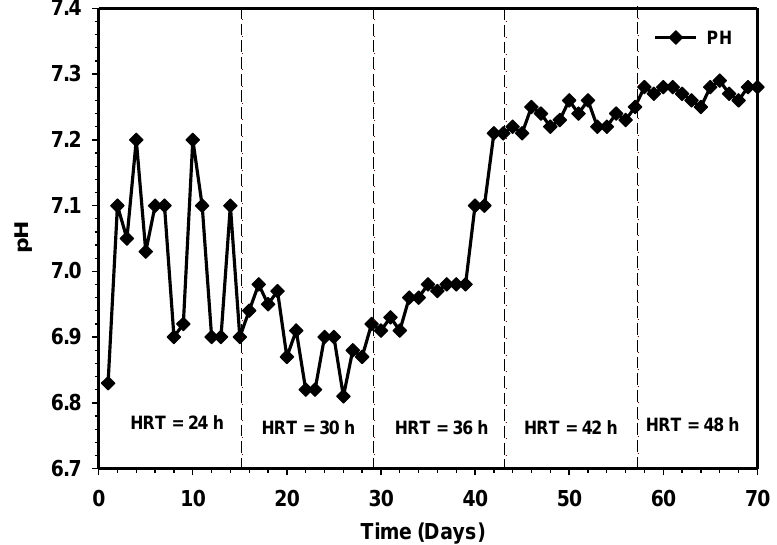
Figure 8. Variation of pH relative to increasing contact time.